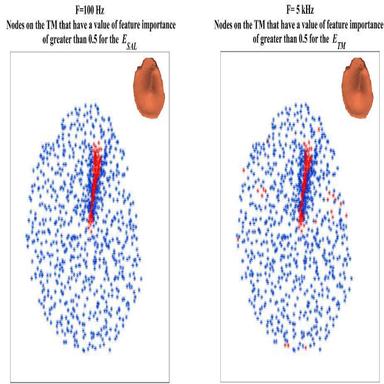
Left: all sample nodes on the TM with the nodes that have values of feature importance of greater than 0.5 for the Young's modulus of SAL at 100 Hz shown in red (187 nodes). Right: all sample nodes on the TM with the nodes that have values of feature importance of greater than 0.5 for the Young's modulus of TM at 5 kHz shown in red (173 nodes).